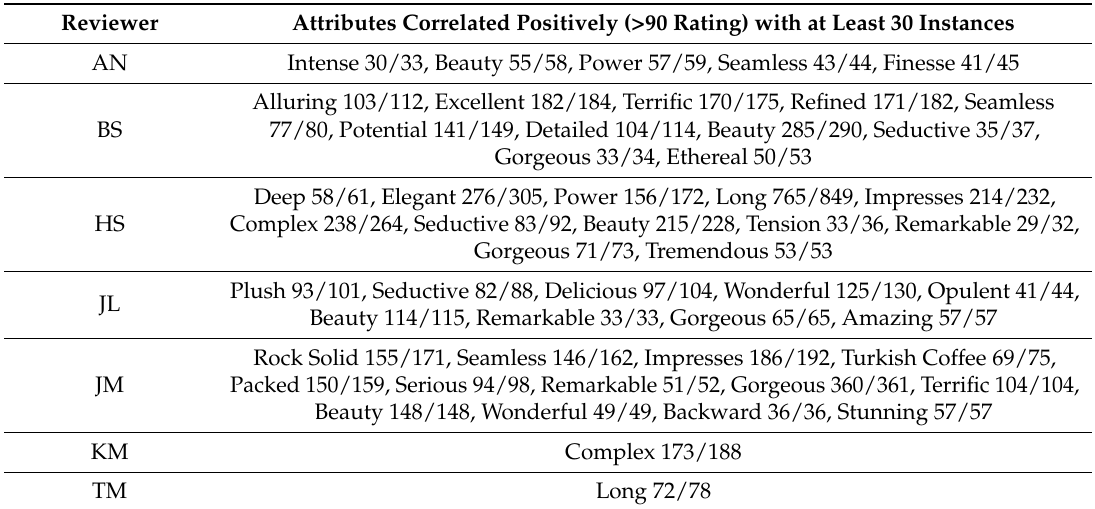
Table 6. Naïve Bayes Positively Correlated